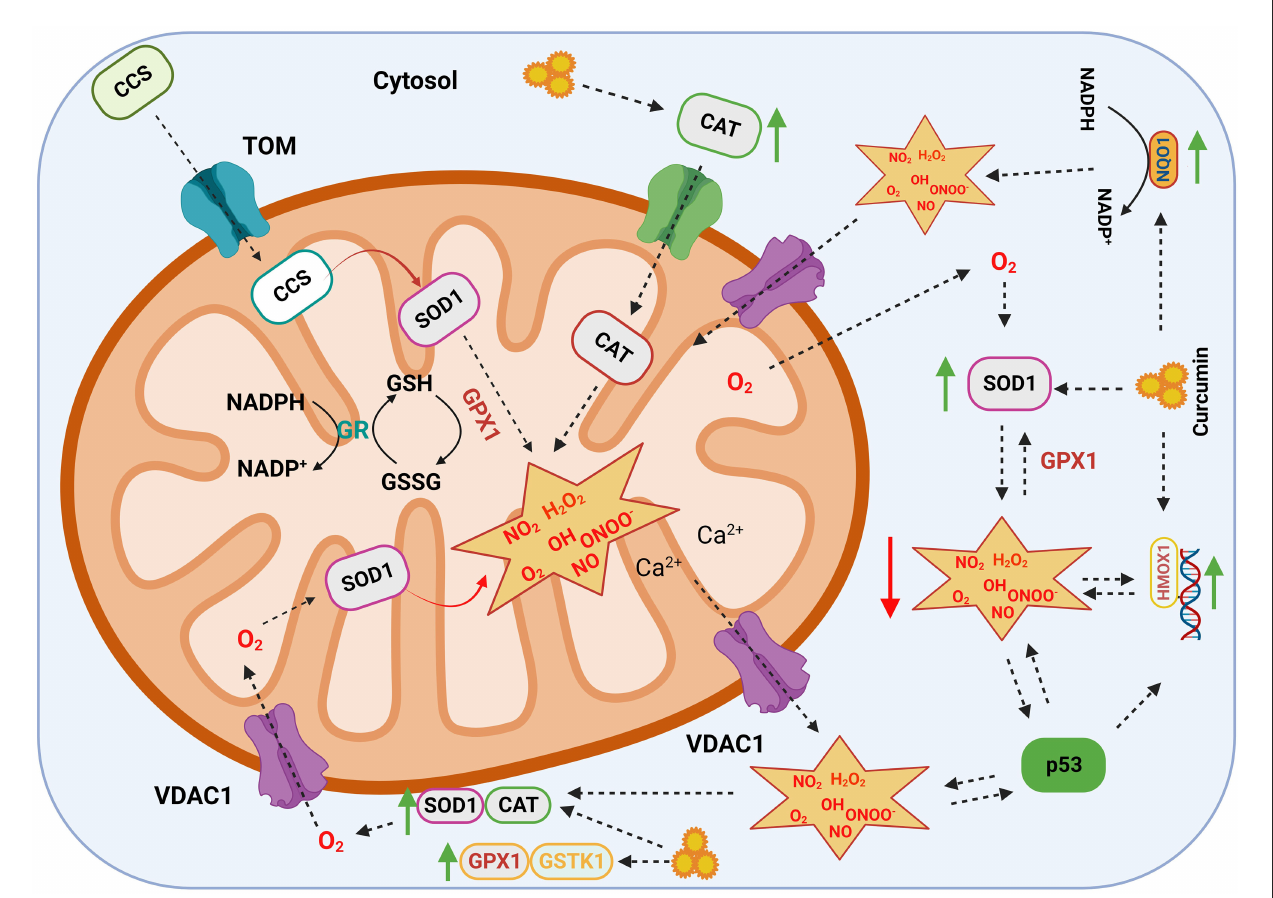
FIGURE2 Antioxidant mechanism of curcumin. Schematic diagram summarizing a network of antioxidant enzymes regulating the formation of reactive oxygen species (ROS), which are involved in a number of cellular reactions. Curcumin upregulates antioxidant enzymes such as GPX1, GSTK1, SOD1, CAT, NQO1, and HMOX1. The ROS present in the cytoplasm are transported to the mitochondrion through gatekeeper proteins such as VDAC1 where they are scavenged by antioxidant enzymes. SOD1, superoxide dismutase; CAT, catalase; GPX1, glutathione peroxidase; GSTK1, glutathione-s-transferase kappa; HMOX1, heme oxygenase; NQO1, NAD (P) H quinone dehydrogenase; VDAC1, voltage-dependent anion channel; TP53, cellular tumor antigen p53; CCS, copper chaperone for SOD; GR, glutathione reductase; NO 2 , nitrogen dioxide; H 2 O 2 , hydrogen peroxide; OH, hydroxyl radical; O 2 , superoxide; NO, nitric oxide; ONOO − , peroxynitrite. The green arrow represents upregulation and the red arrow represents